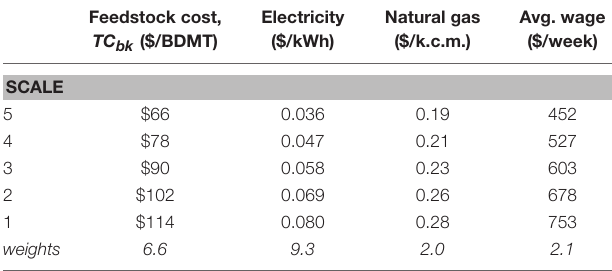
TABLE 3 | Satellite depot decision matrix for spokane